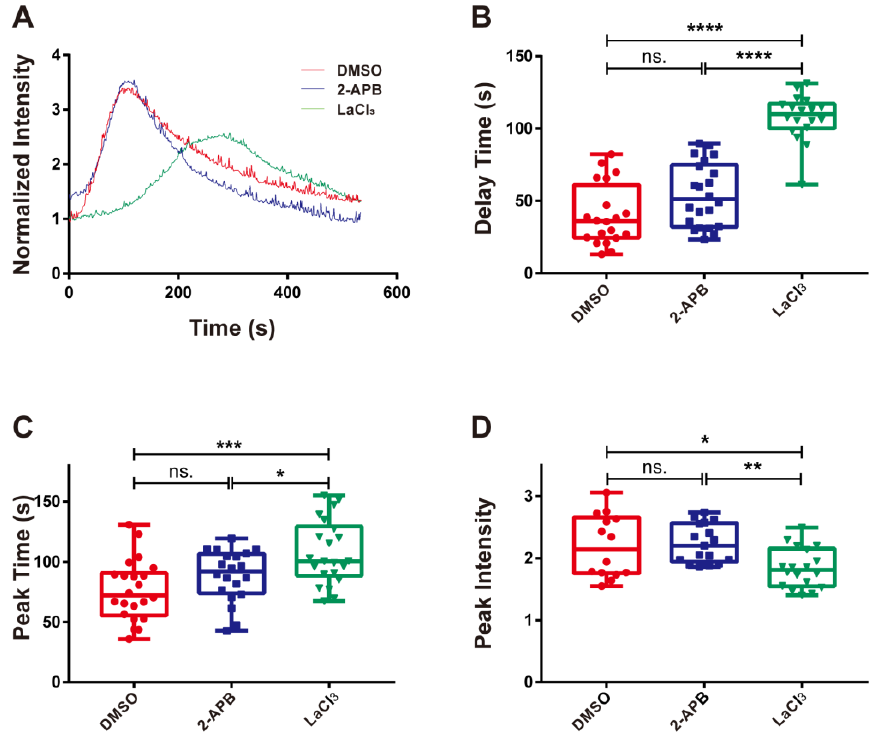
Figure 5. The effects of blocking the membrane calcium channel on calcium signaling. ( A ) Time course, ( B ) delay time, ( C ) peak time, and ( D ) peak intensity of integrin α 4 β 7/MAdCAM-1 complex- induced calcium signaling of RPMI 8226 cells treated with the membrane calcium channel blocker LaCl 3 and the IP3 inhibitor 2-APB or dimethyl sulfoxide (DMSO). The adhesion of RPMI 8226 cells was at a wall shear stress of 0.3 dyn/cm 2 . Data of each group were shown by boxplot with raw data point, wherein each horizontal line from top to bottom of a boxplot represents the maximum, upper quartile, median, lower quartile, and minimum for the group, respectively. At least 15 typical calcium signaling events of the firmly adhering cells should be collected among three repeat experiments for each group. The significant level of difference with the DMSO control group is shown by p -value, with ns. for p > 0.05, * for p < 0.05, ** for p < 0.01, *** for p < 0.001, and **** for p < 0.0001.